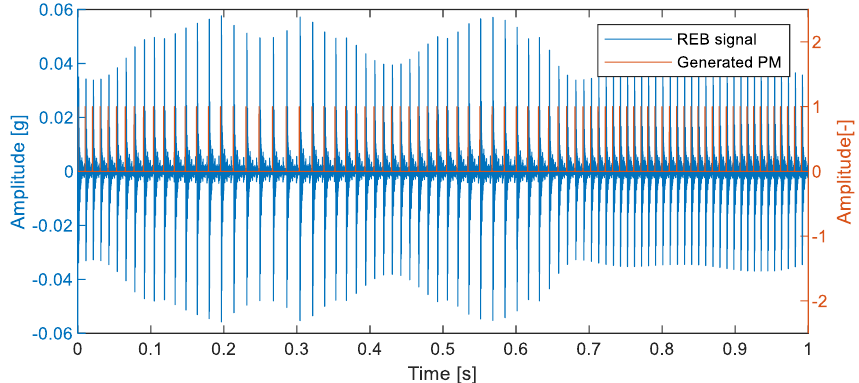
Figure 16. Generated phase marker signal.